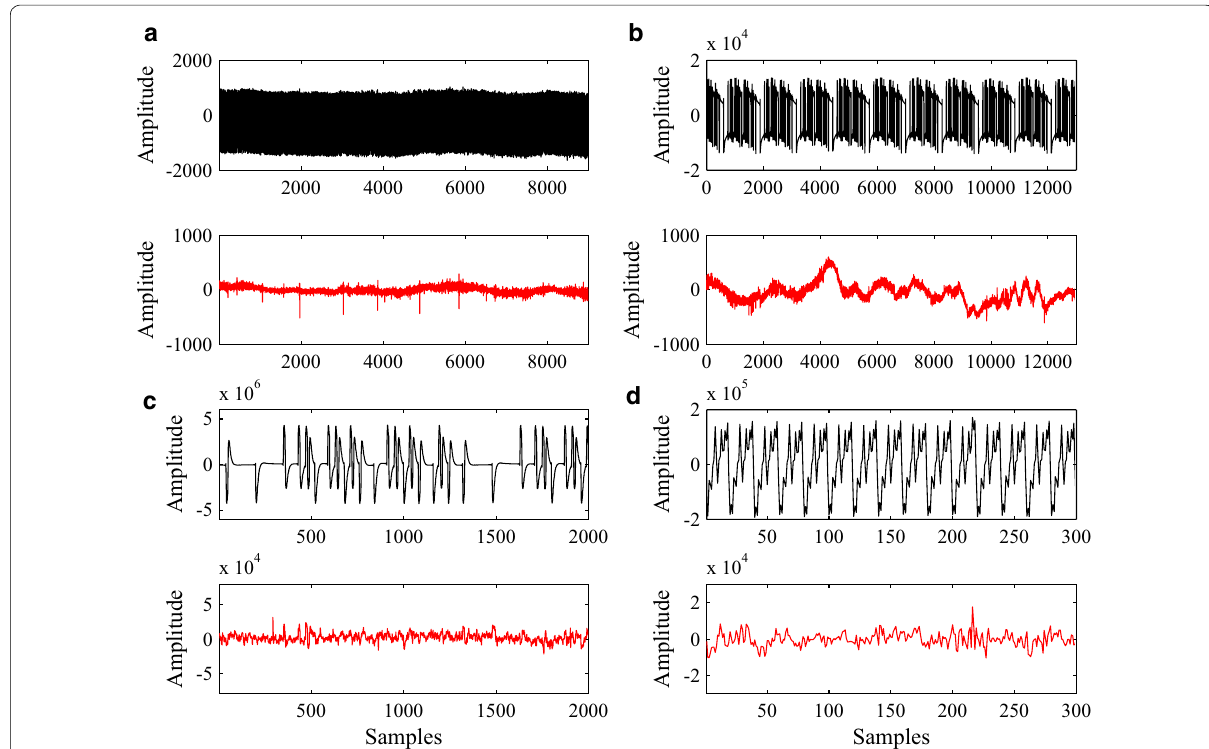
Fig. 8 Raw (black) and de-noised (read) time-series segments from the data set D 1 of the station QH401504, a sampling rate of 15 Hz. a Ex component. b Ey component. c Hx component. d Hy component